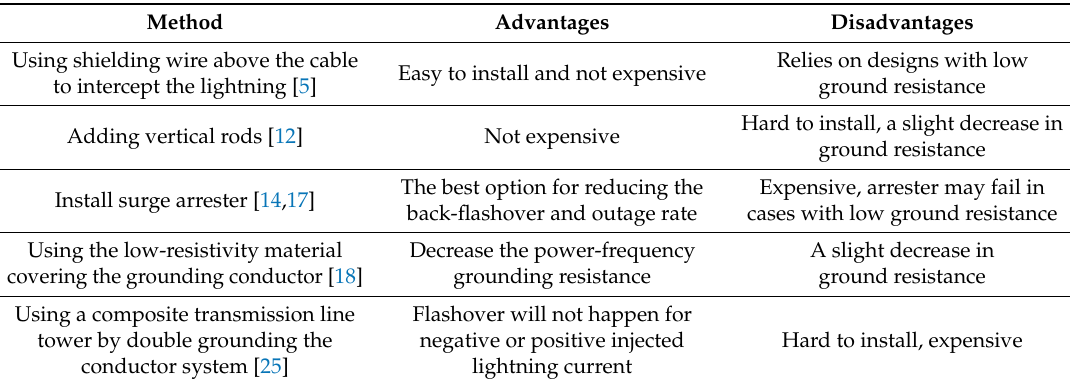
Table 1. Systems of protection for distribution